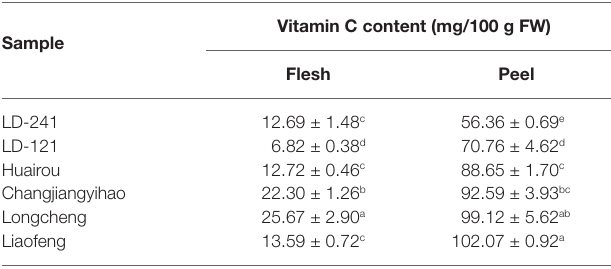
5.77 μ g/g FW (Huairou). The free proanthocyanidin B2 contents of peel extracts ranged from 2.95 μ g/g FW (LD-121) to 9.59 μ g/g FW (Huairou). The free proanthocyanidin C1 contents of flesh extracts ranged from 0.32 μ g/g FW (Huairou) to 2.57 μ g/g FW (LD-241). The free proanthocyanidin C1 contents of peel extracts ranged from 2.44 μ g/g FW (Huairou) to 3.92 μ g/g FW (Liaofeng). The flavanol contents of the peel extracts were higher than those of corresponding flesh extracts among all six kiwi berry varieties. Three flavonols, i.e., quercetin-3- O -glucoside, quercetin-3- O -rutinoside, and quercetin-3- O -galactoside were only found in free fractions. The free quercetin-3- O -glucoside contents of flesh extracts ranged from 1.64 μ g/g FW (Longcheng) to 4.79 μ g/g FW (Liaofeng). The free quercetin-3- O -glucoside contents of peel extracts ranged from 4.62 μ g/g FW (Longcheng) to 16.57 μ g/g FW (LD-241). The free quercetin-3- O -rutinoside contents of flesh extracts ranged from 2.52 μ g/g FW (LD-121) to 5.52 μ g/g FW (Longcheng). The free quercetin-3- O -rutinoside contents of peel extracts ranged from 5.51 μ g/g FW (LD-121) to 20.08 μ g/g FW (Longcheng). The free quercetin-3- O -galactoside contents of flesh extracts ranged from 1.88 μ g/g FW (Huairou) to 6.14 μ g/g FW (Changjiangyihao). The free quercetin-3- O - galactoside contents of peel extracts ranged from 12.48 μ g/g FW (LD-121) to 22.70 μ g/g FW (Changjiangyihao). The flavonol contents of the peel extracts were higher than those of corresponding flesh extracts among all six kiwi berry varieties. The PSC values of the flesh ( Figure 4A ) and peel ( Figure 4B ) extracts of the six kiwi berry varieties are shown in Figure 4 . The free PSC values were significantly higher than those of the corresponding bound PSC values for both the flesh and peel extracts. As shown in Figure 4A , the free PSC values of flesh extracts ranged from 456.64 μ mol VCE/100 g FW (LD-121) to 1053.60 μ mol VCE/100 g FW (Longcheng), whereas the bound PSC values of flesh extracts ranged from 77.81 μ mol VCE/100 g FW (Changjiangyihao) to 184.62 μ mol VCE/100 g FW (Huairou). As shown in Figure 4B , the free PSC values of peel extracts ranged from 2855.71 μ mol VCE/100 g FW (LD-241) to 4630.56 μ mol VCE/100 g FW (Liaofeng), whereas the bound PSC values of flesh peel ranged from 116.40 μ mol VCE/100 g B FW (Longcheng) to 264.46 μ mol VCE/100 g FW (Huairou). T A